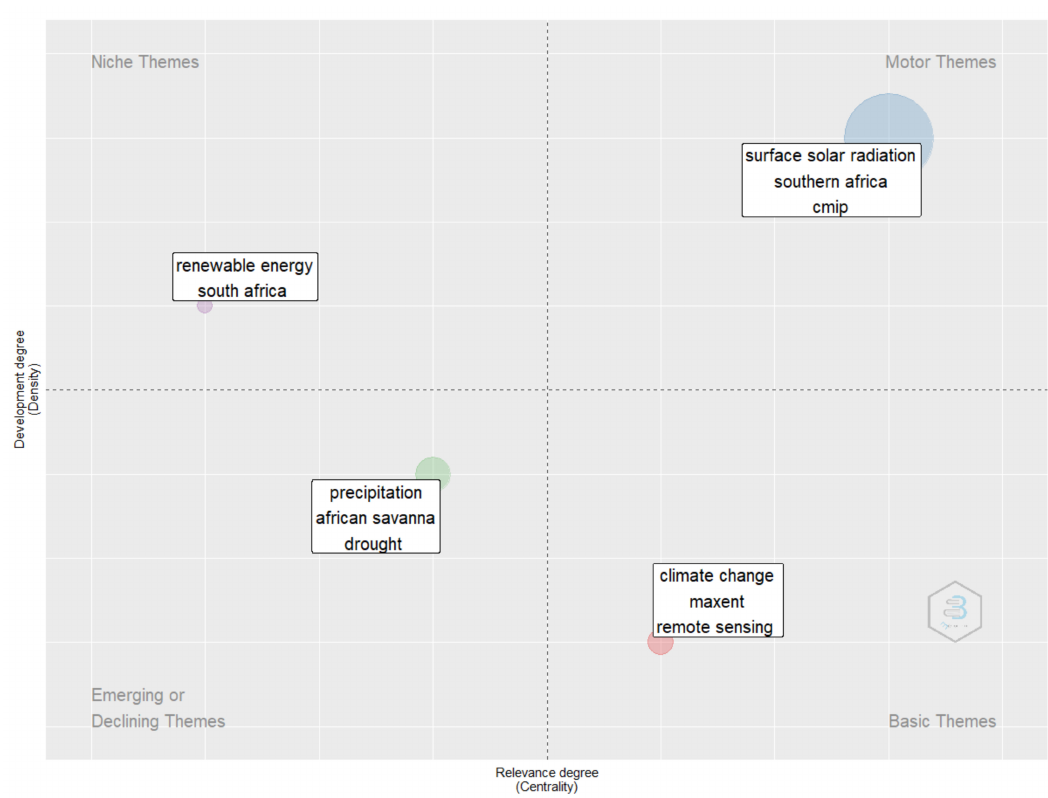
Figure 7. A thematic network of themes from African data.